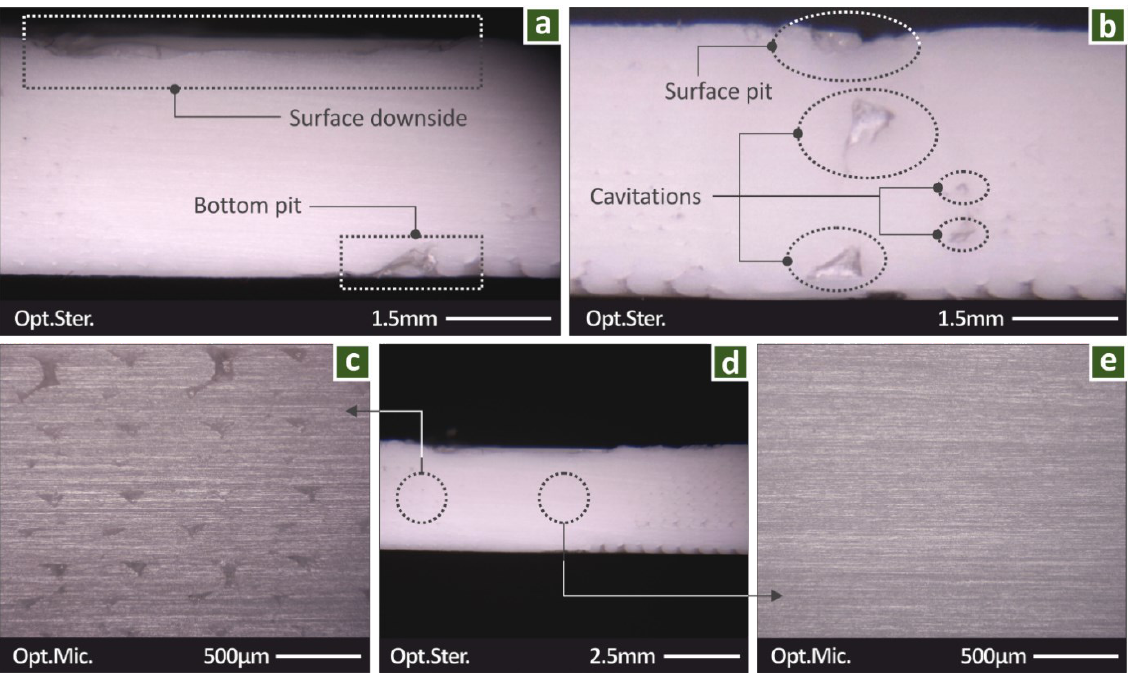
Figure 7. Side views of the welded specimens: ( a , b ) stereoscopic images of the HAZ, and HAZ limits, ( c ) view outside the welding zone, ( d ) stereoscopic image at lower magnification, and ( e ) view of the welding zone.